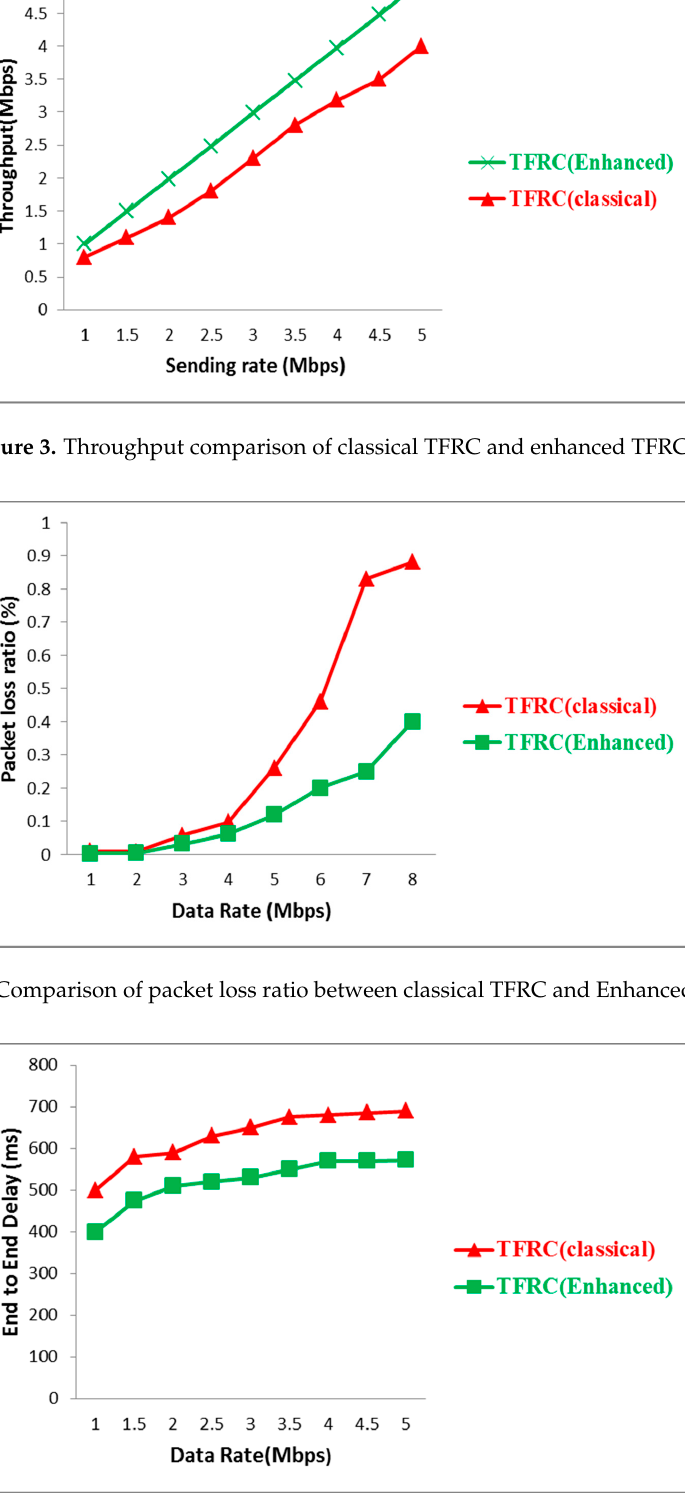
Figure 5. Comparison of End-to-End delay between classical TFRC & Enhanced TFRC.